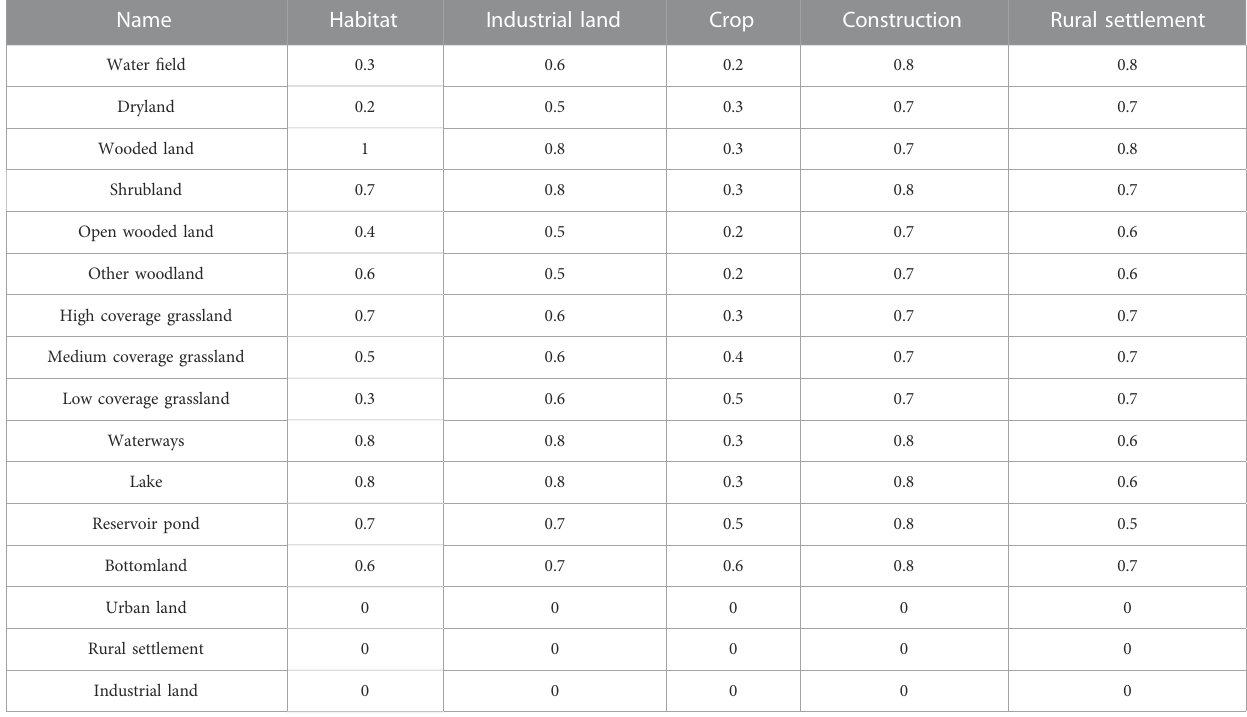
TABLE 3 Habitat sensitivity data.